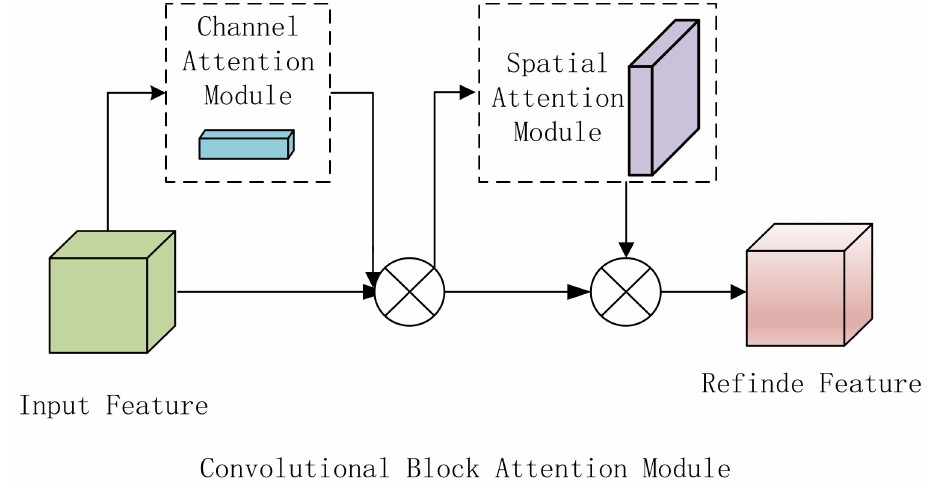
Figure 7. CBAM module